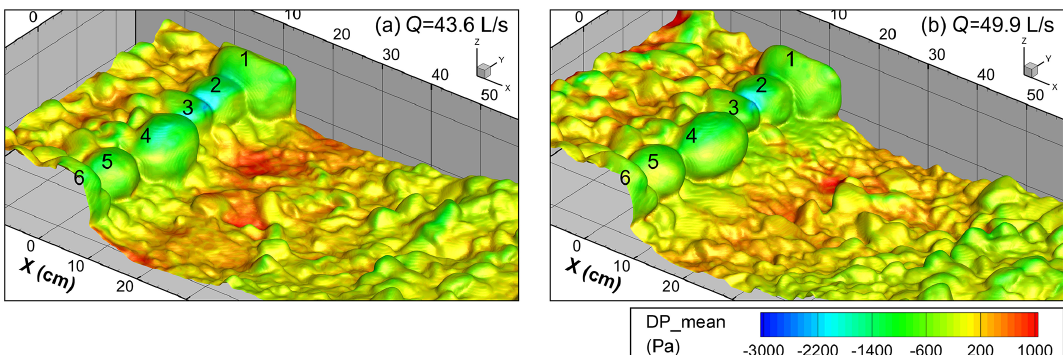
Figure 9. Time-averaged dynamic pressure (DP_mean) on the bed surface in the step-pool model under the two highest discharges, with the step numbers marked. The negative values in the plots result from the setting of standard atmospheric pressure to 0Pa, the absolute value of which is 1.013 × 10 5 Pa.